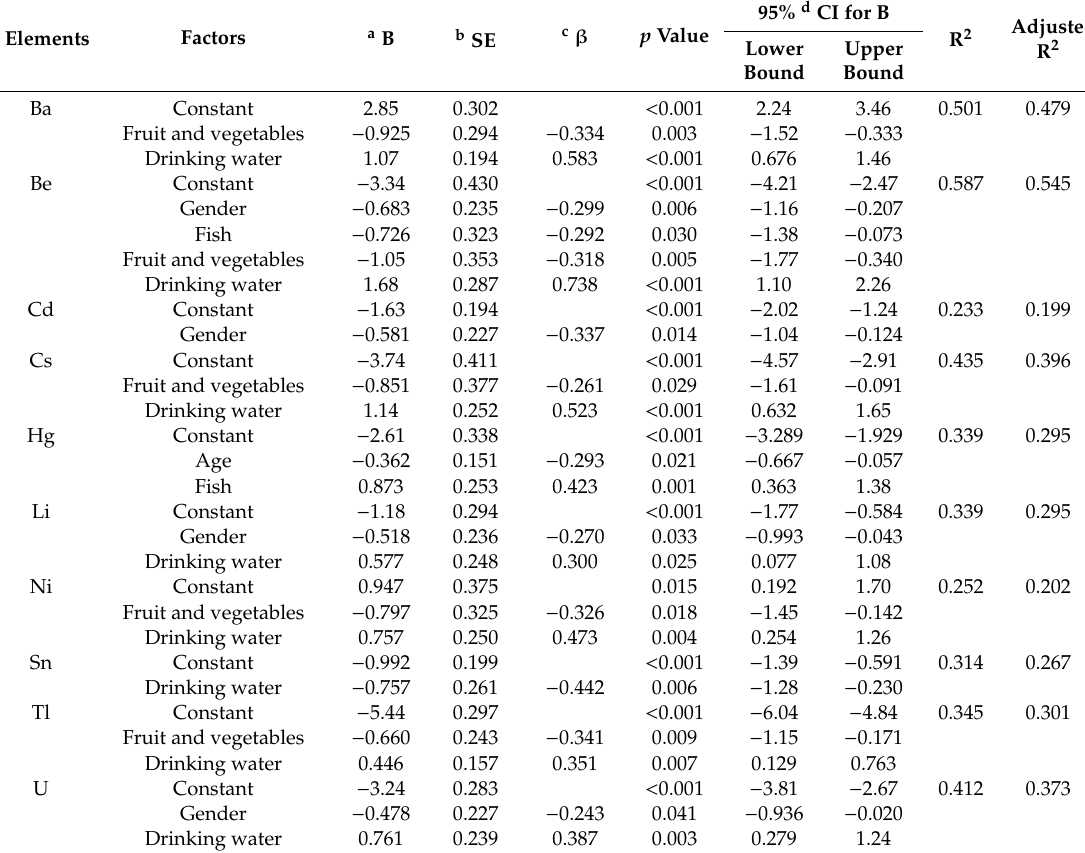
Table 6. Results of the backward multiple linear regression model analysis for some toxic